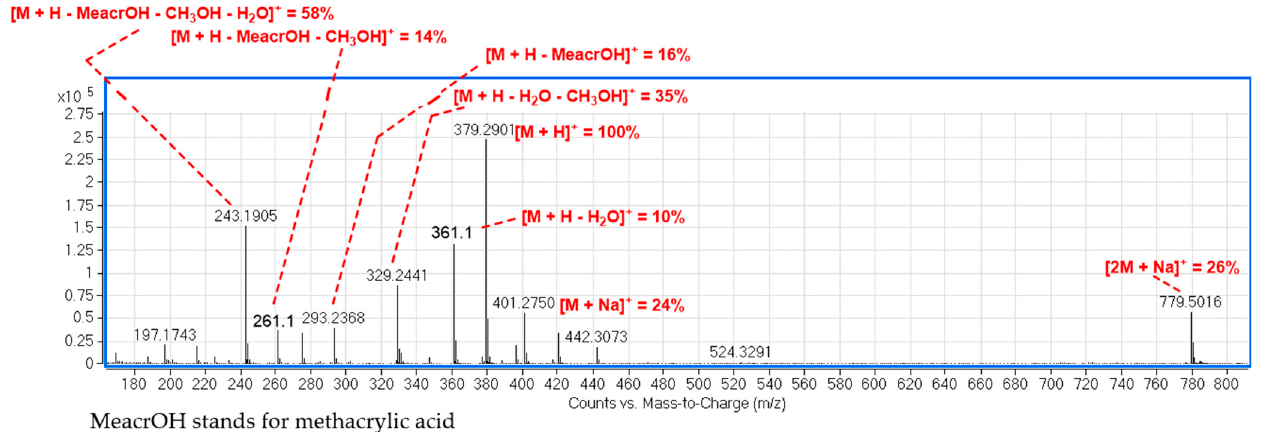
Figure 5. ESI-ToF-MS of peak XIV.